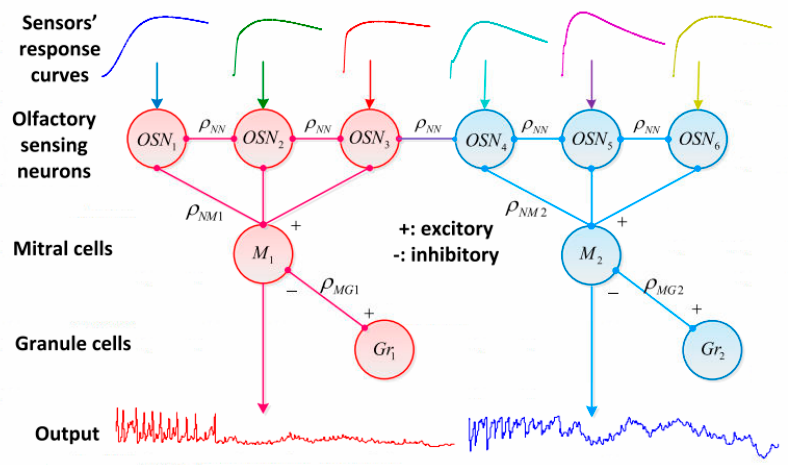
Figure 16. Biological neuron and its association with an artificial spiking neuron. Reprinted with permission from Ref. [114]. Copyright year 2020, copyright owner Elsevier.